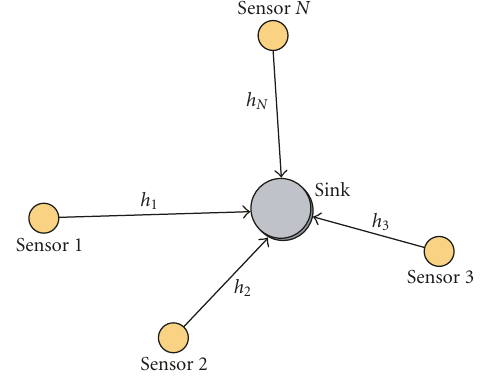
Figure 1: Wireless sensor network scheme: a centralized configura-